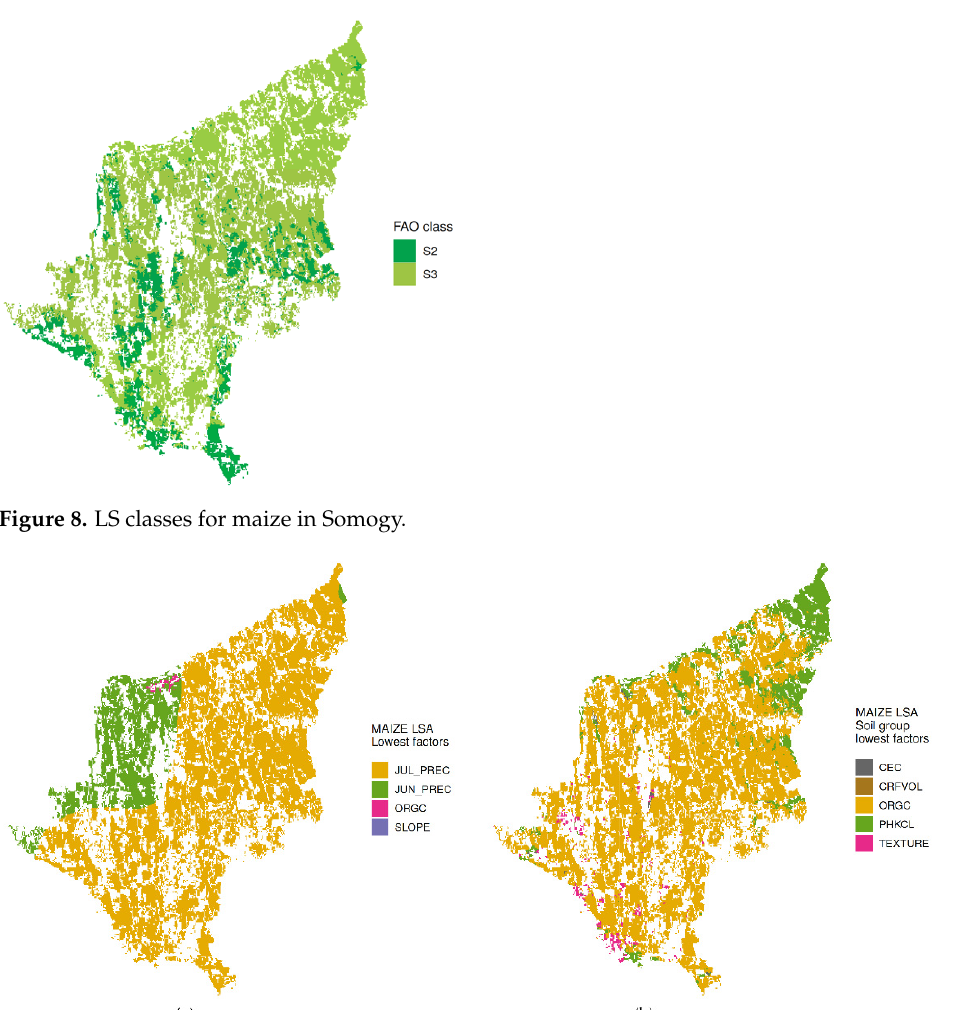
Figure 7. Suitability score maps of input parameters for maize in Somogy, where: ( a ) climatic factors; ( b ) soil factors; ( c ) topographic factors.